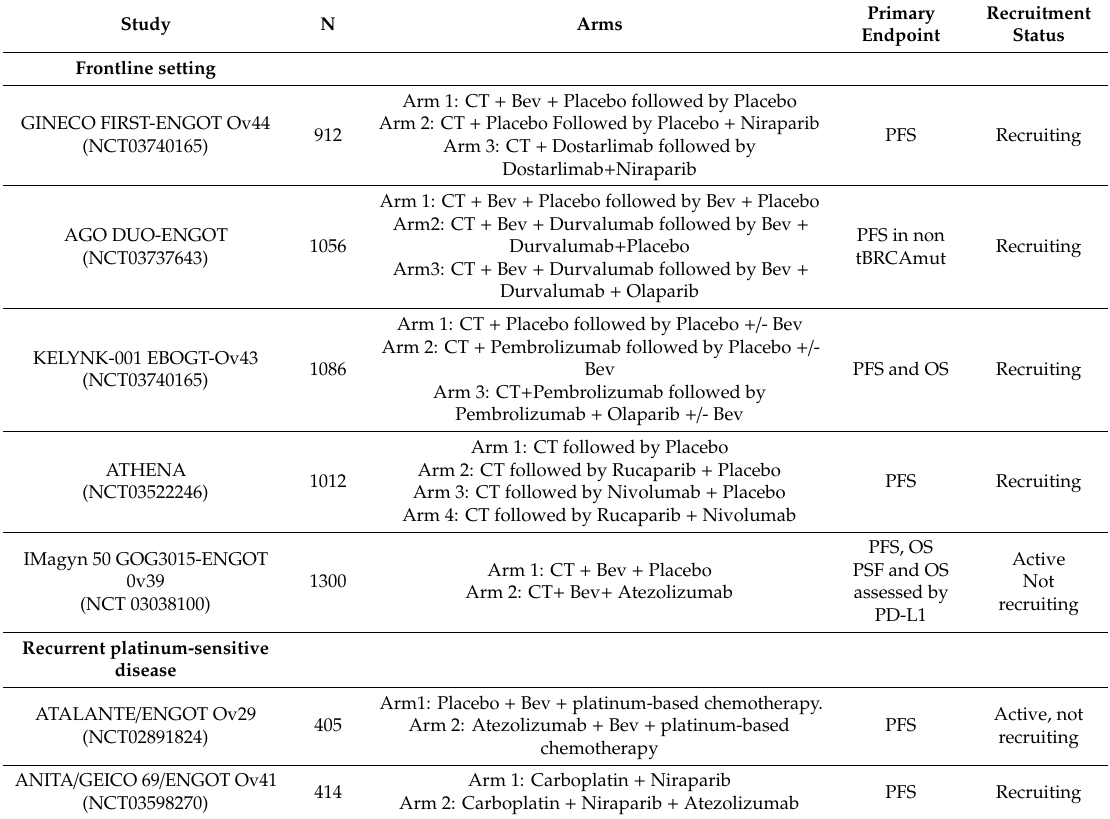
Table 2. Ongoing Phase III ICB, PARPi and / or Anti-VEGF